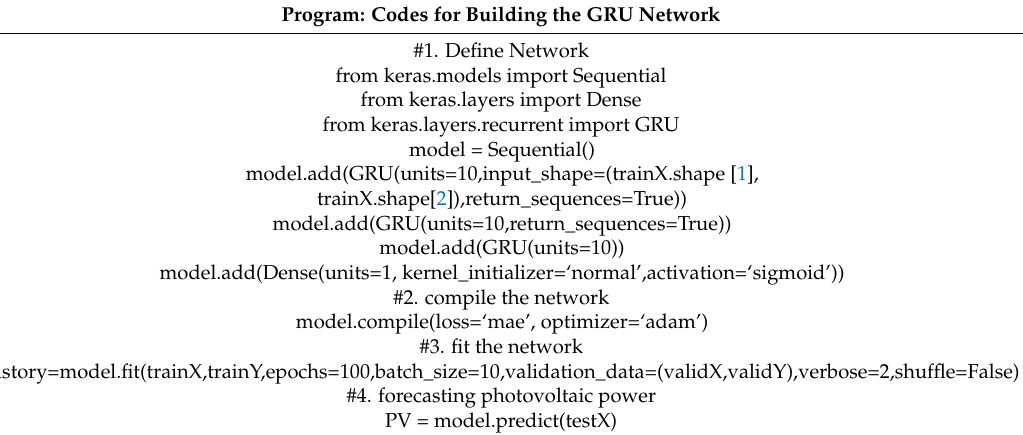
Table 2. GRU architecture based on Keras. Program: Codes for Building the GRU